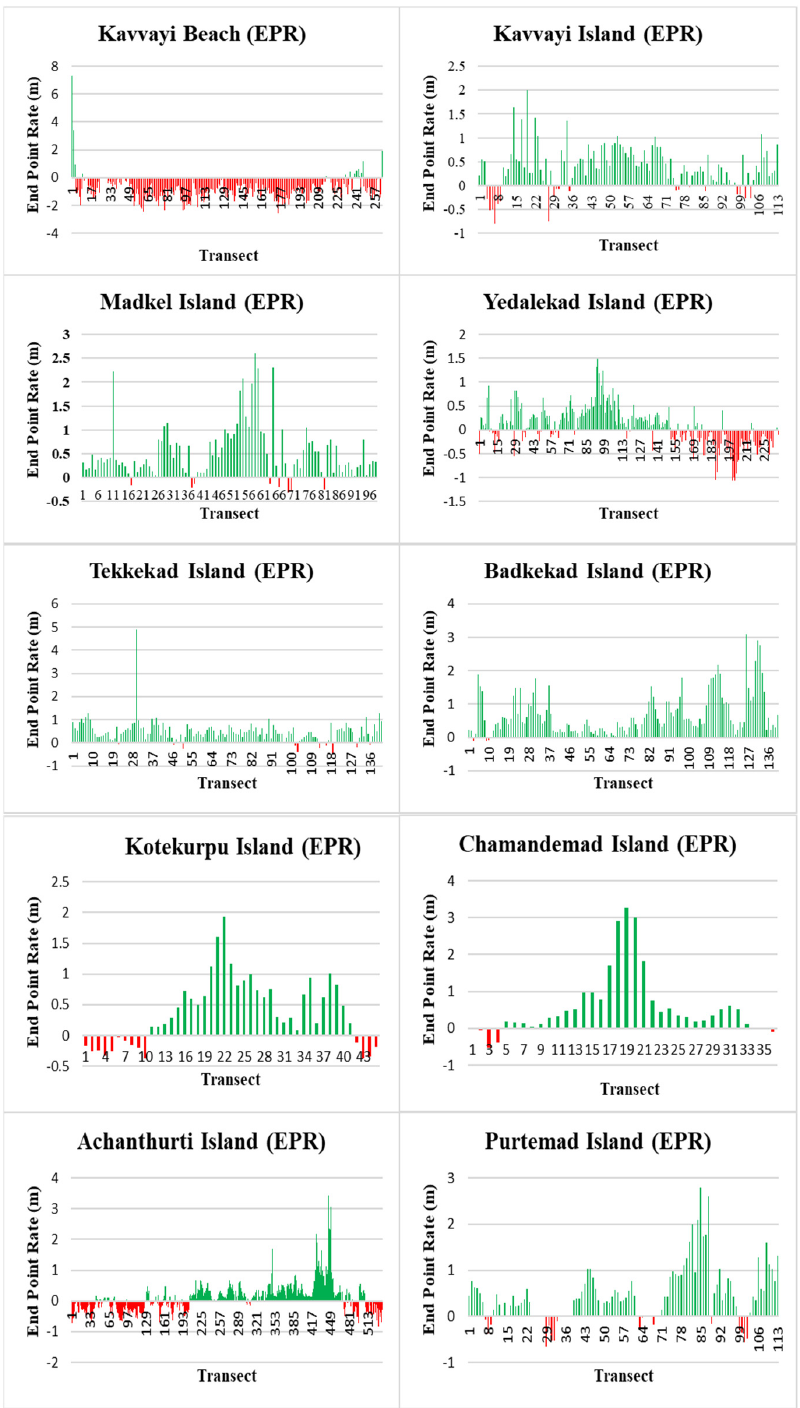
Figure 5. Bar graphs representing End Point Rate (EPR) of Kavvayi beach, Kavvayi island, Madkel island, Yedalekad island, Tekkekad island, and Badkekad islands of Kotekurupu island, Chamandemad island, Achanthurti island, and Purtemad island of Kavvayi wetland . EPR rates gave insights into observations, which were already obtained from various other DSAS methodologies followed in this study, such as the erosional process being